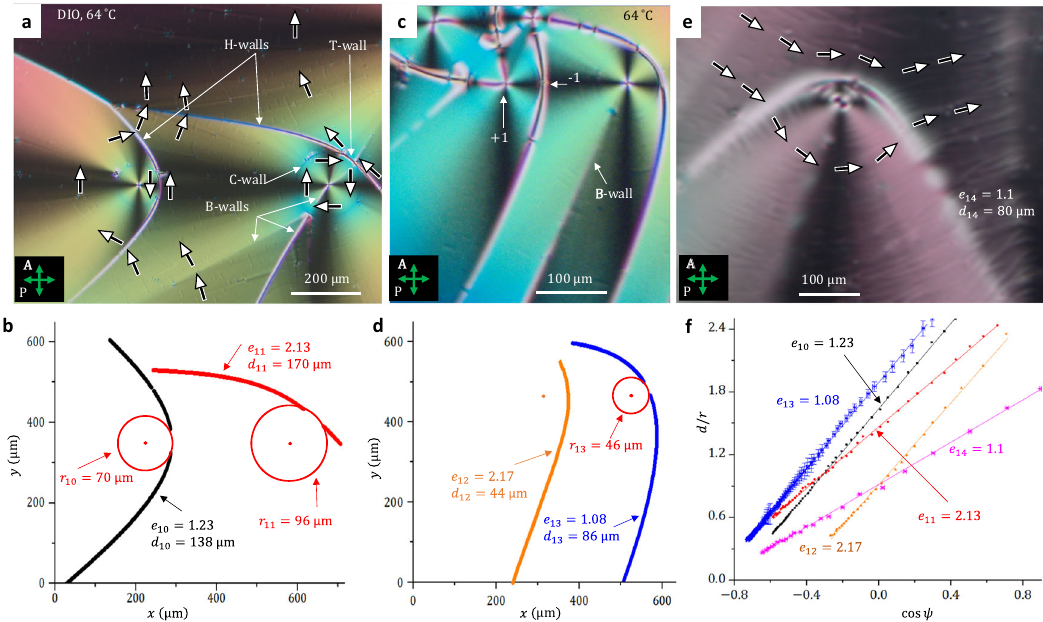
to the bottom of the texture. d The corresponding eccentricities and distances to thedirectrixfortheH-wallsinpart( c ). e PolarizingmicroscopytextureofanH-wall in an aged sample; accumulated impurities decorate the director fi eld; h ≈ 10 μ m.